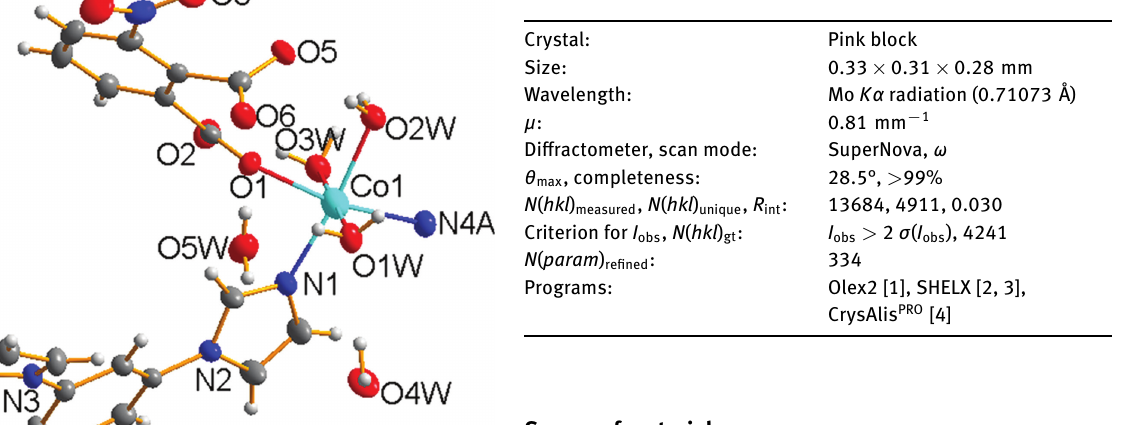
Table 1: Data collection and